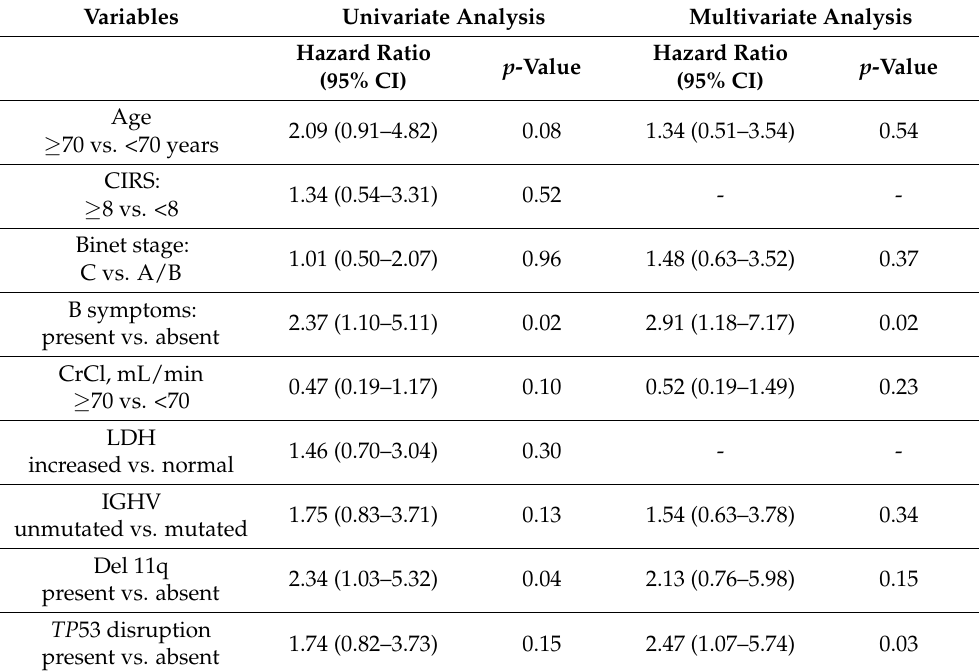
Table 2. Impact of baseline factors on progression-free survival: univariate and multivariate analysis.